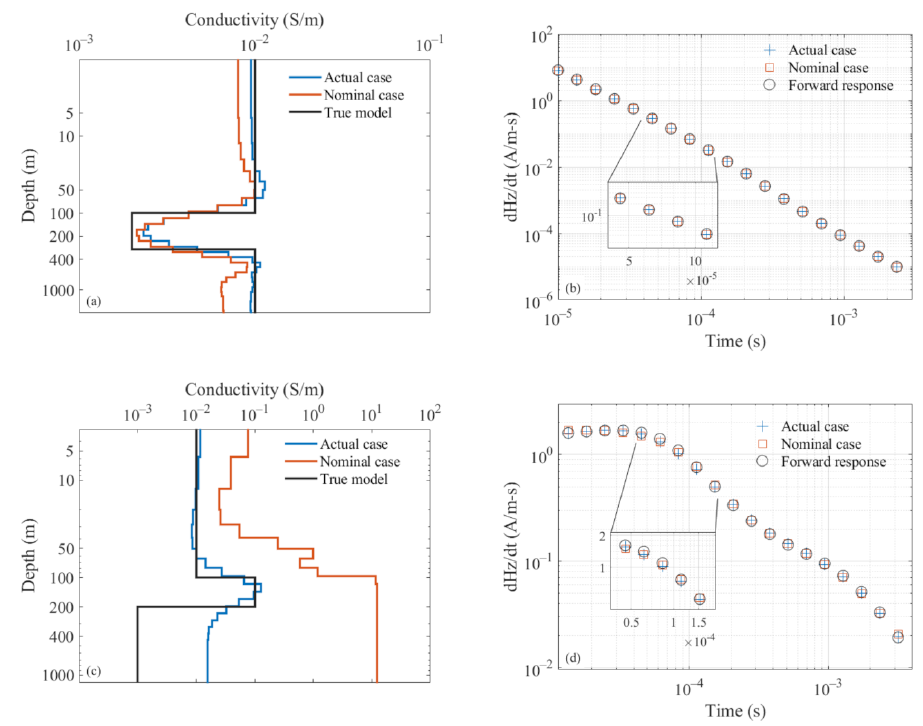
Figure 6. The effect of inexact geometry on the inversion results. ( a , b ) ATEM: tilted central-loop configuration; ( c , d ) SATEM: crooked grounded long wire and tilted receiver coil. Detailed survey parameters are presented in Section